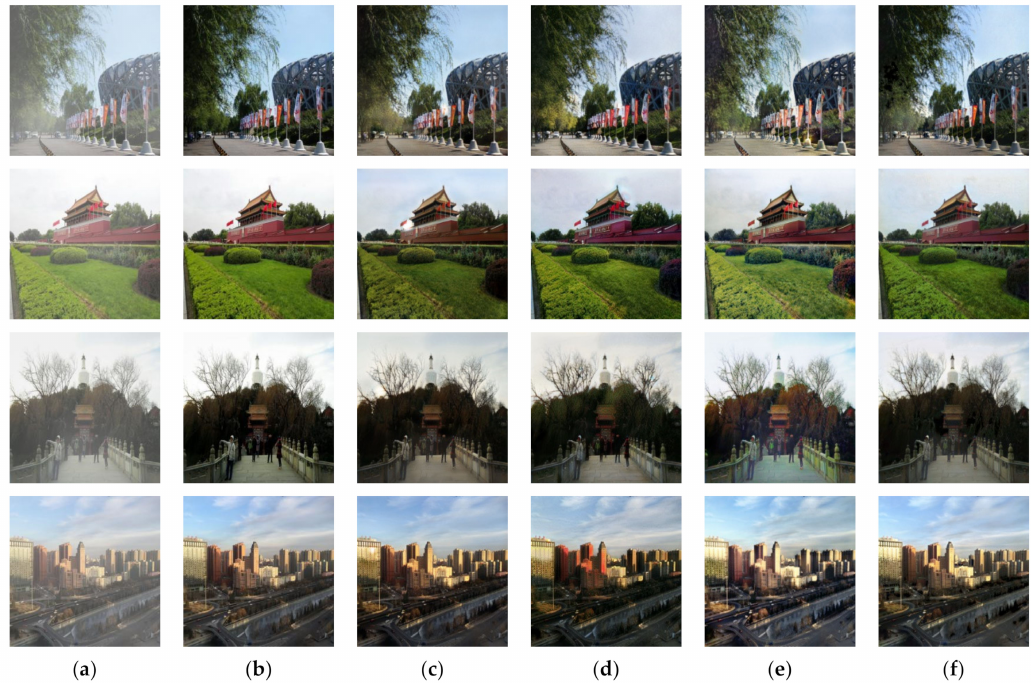
Figure 12. Visual results on the HSTS dataset: ( a ) hazy images; ( b ) corresponding haze-free images;